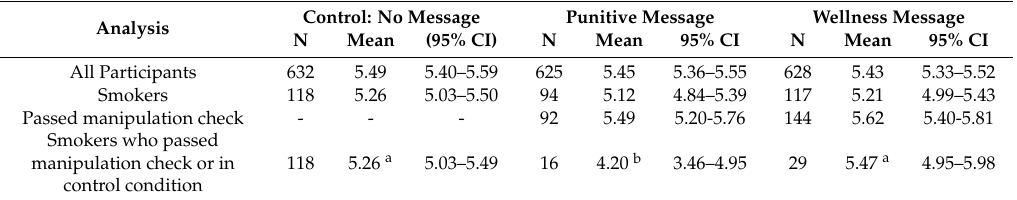
Table 2. Perceived organizational support by condition, college students, spring